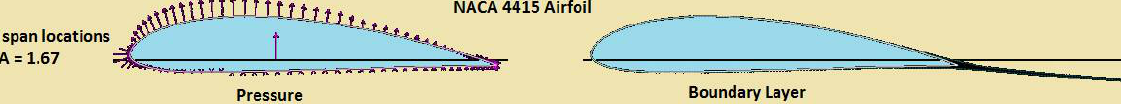
Figure 7. Spanwise aerodynamic properties of the light aircraft solo propeller at design point analyzed using py_BEM.